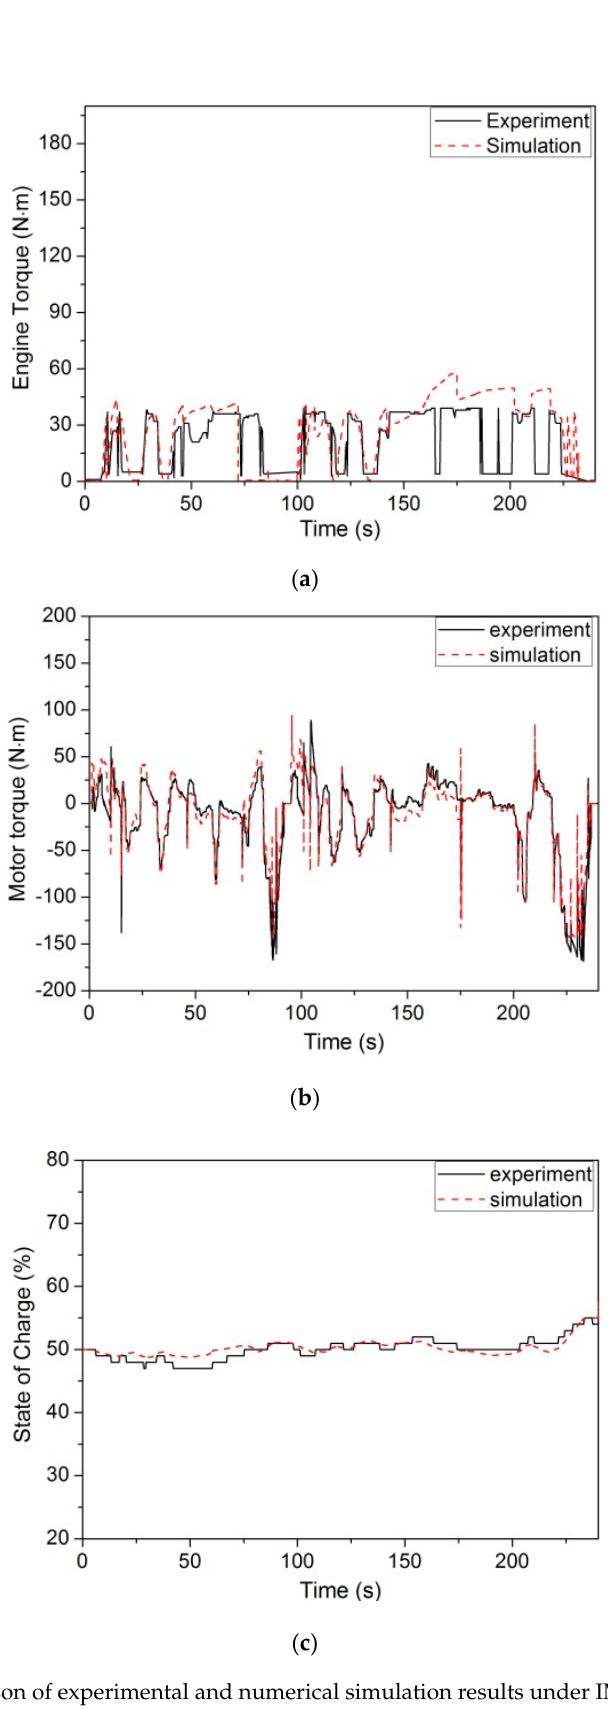
Figure 6. Comparison of experimental and numerical simulation results under IM240-mode driving: ( a ) engine torque; ( b ) driving motor torque; ( c ) state of charge.